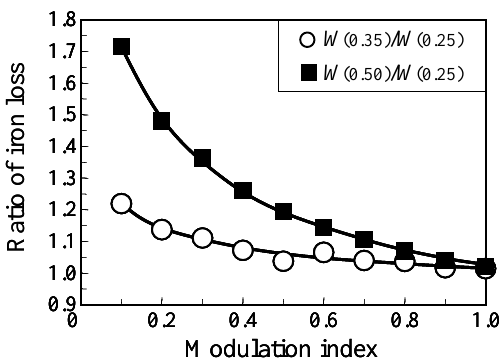
Figure 10. Dependence of iron loss on modulation index under PWM excitation. Maximum flux density: 1.5 T, fundamental frequency: 50 Hz, carrier frequency: 1.0 kHz.